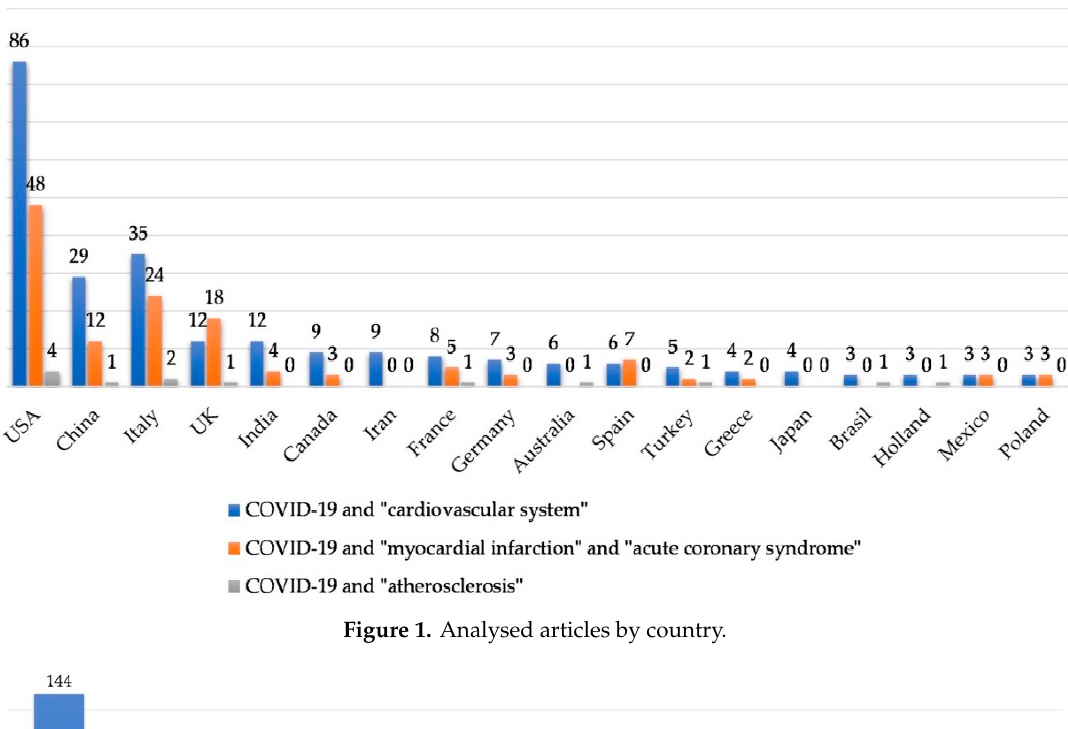
Figure 2. Types of articles analysed by search words.